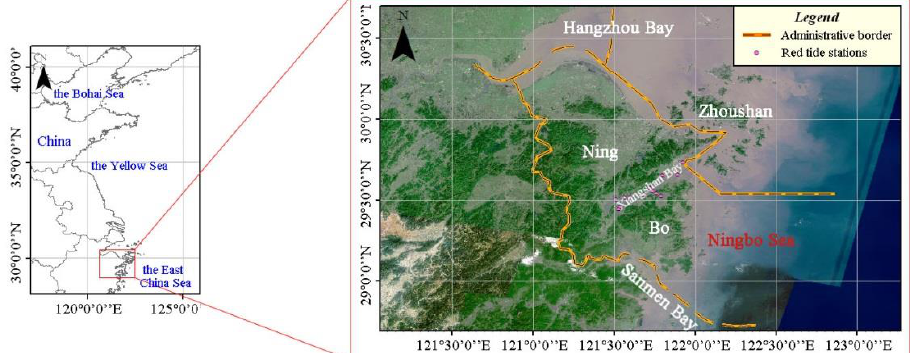
Figure 5. Map of Ningbo Sea and its adjacent areas.